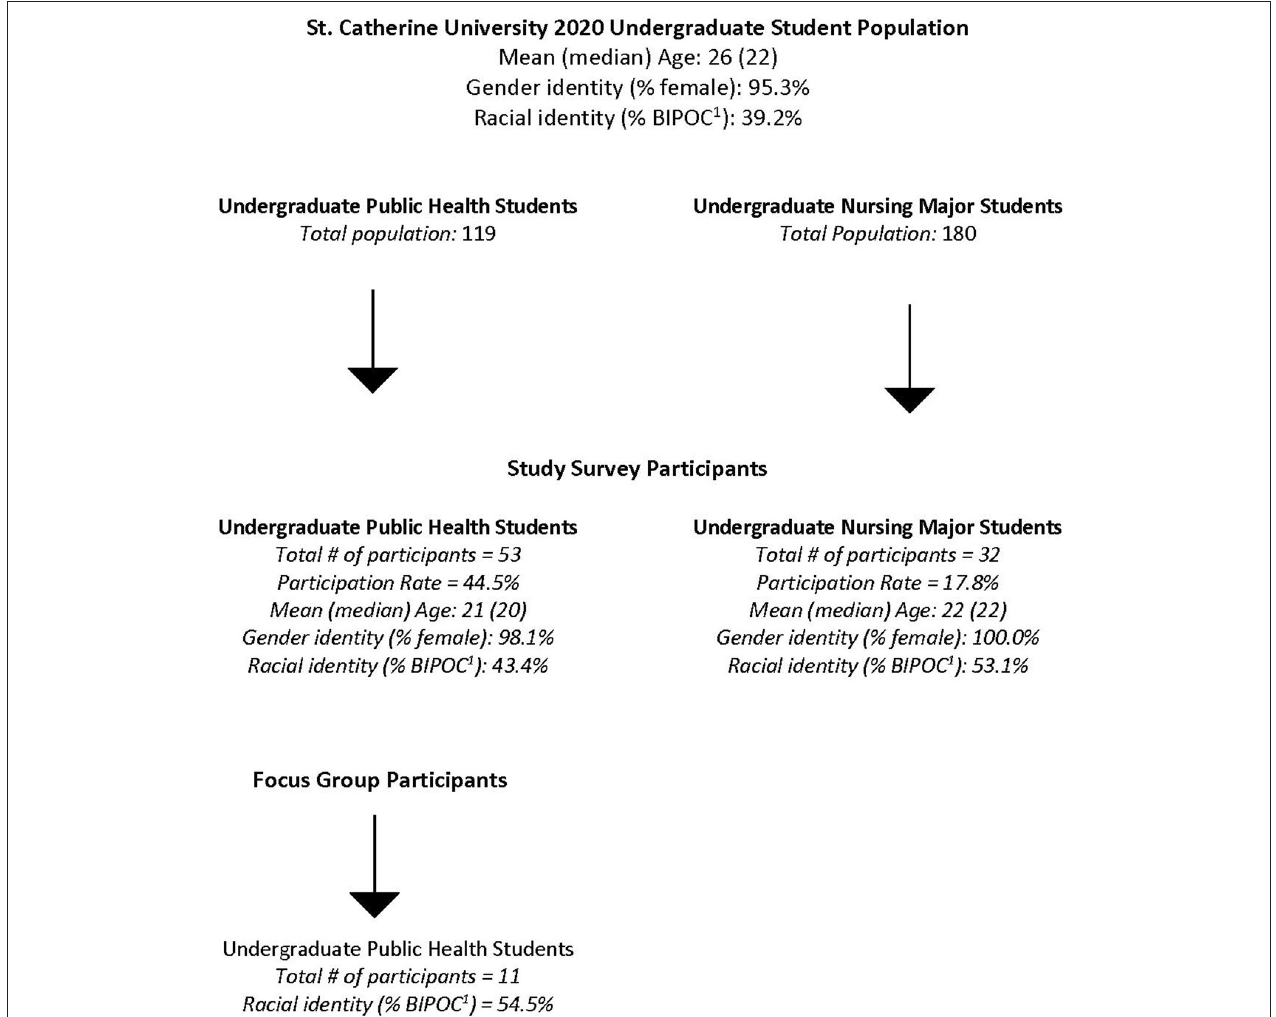
FIGURE 1 | BIPOC includes a student who self-identifies as being in one of the following racial/ethnic categories: Hispanic, Asian-American, African American, Native American/Alaska Native, Native Hawaiian/Other Pacific Islander or multiracial.